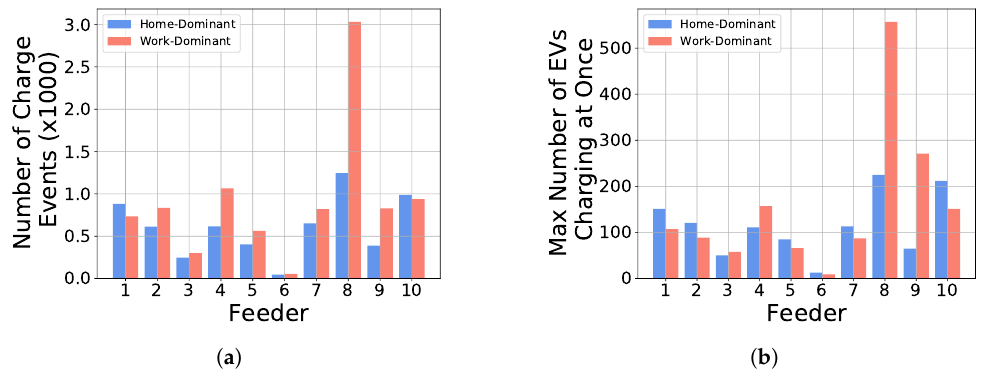
Figure 3. The number of electric vehicles (EV) charging on a particular feeder was different for the home- and work-dominant scenarios. ( a ) The number of EVs charge events ranged from 50 to around 3000. ( b ) The maximum number of EVs charging at once was lowest ( ≈ 6) for feeder 6 and high above 500 for feeder